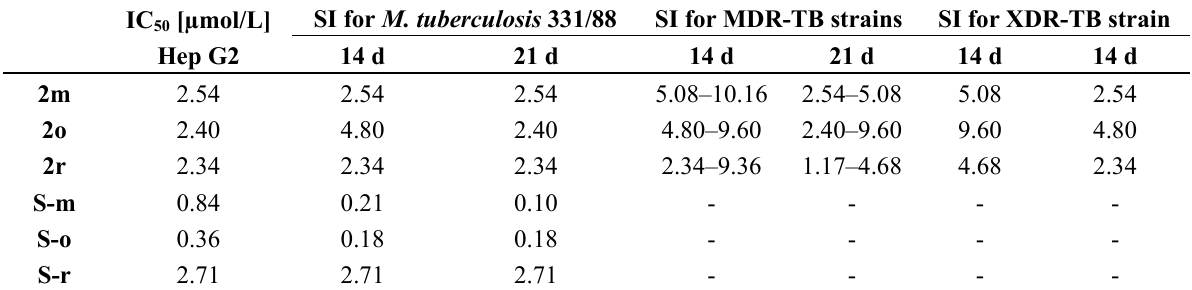
Table 4. Cytotoxicity and selectivity indexes of selected salicylanilides S and their benzoates 1